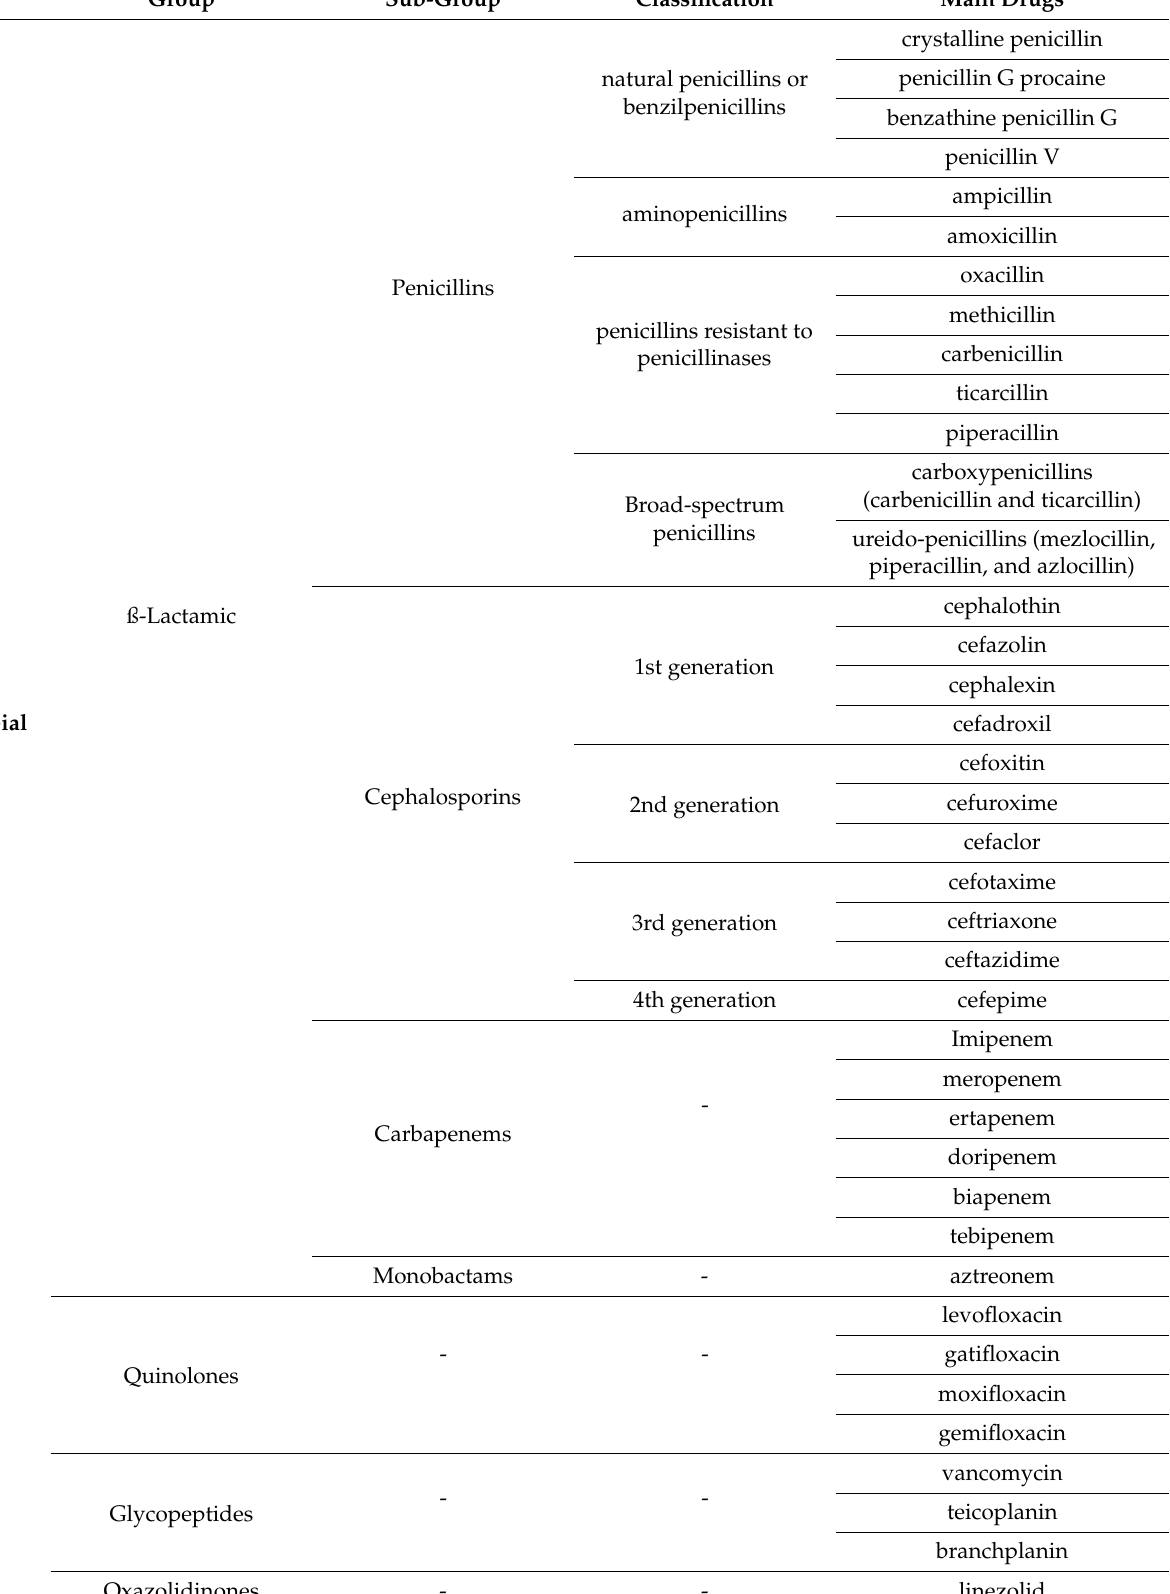
Table 2. Classification of antimicrobial agents according to the Food and Drug Administration (FDA)